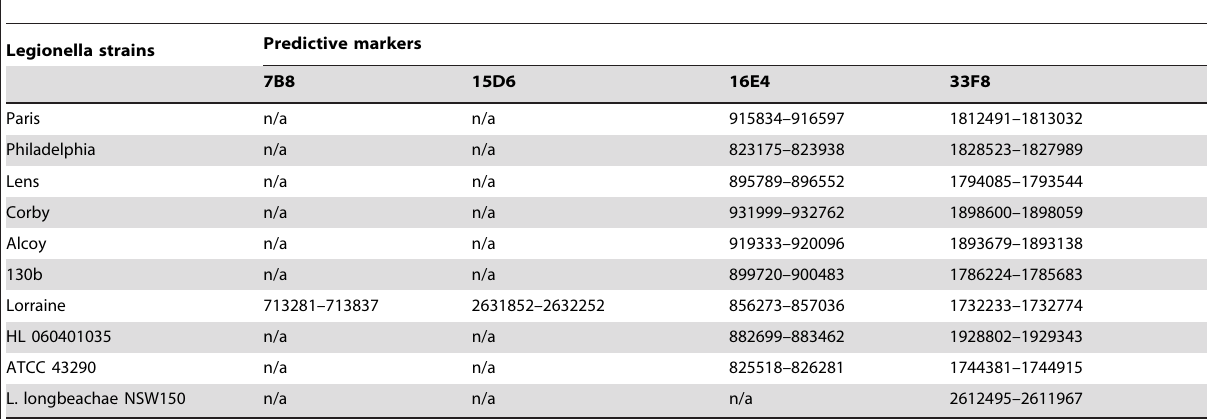
Table 3. Sequence location of the four predictive markers in ten available Legionella